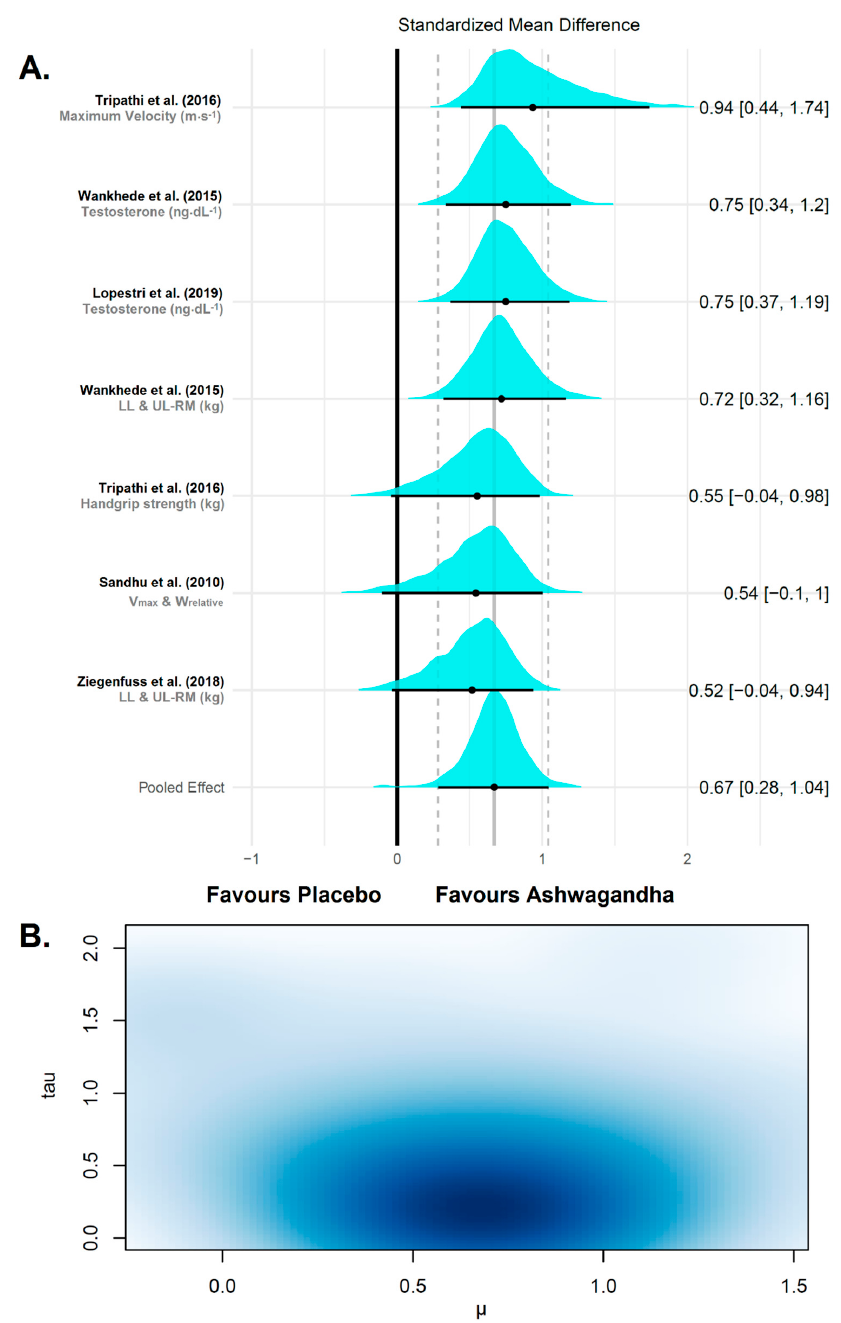
Figure 5. Forest plot of a random effect meta-analysis on strength/power variables after Ashwagandha supplementation. ( A ) The plot shows the names of the studies with their respective variable or multiple comparison/multiple outcomes on the left. On the right are the θ k and 95% credible interval (CrI). The value of the overall weighted mean of effect sizes is drawn as a vertical line in the middle of the plot, which represents the reference line to test the null hypothesis in each study. The posterior distributions of the estimated effect sizes for each study are shown as cyan densities. The black circle represents the posterior mean, and the horizontal line extending from the point is the 95% CrI. The bottom row is the meta-analytic effect size ( μ ). ( B ) Multivariate kernel density estimation plot of the posterior distribution of μ (x-axis) and τ (y-axis) with the darker zone indicating increased plausibility of values.